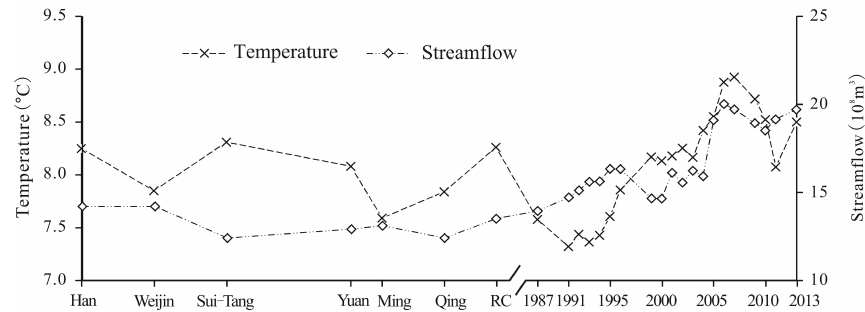
Figure 8. Temporal variations in temperature ( ◦ C) and streamflow (10 8 m 3